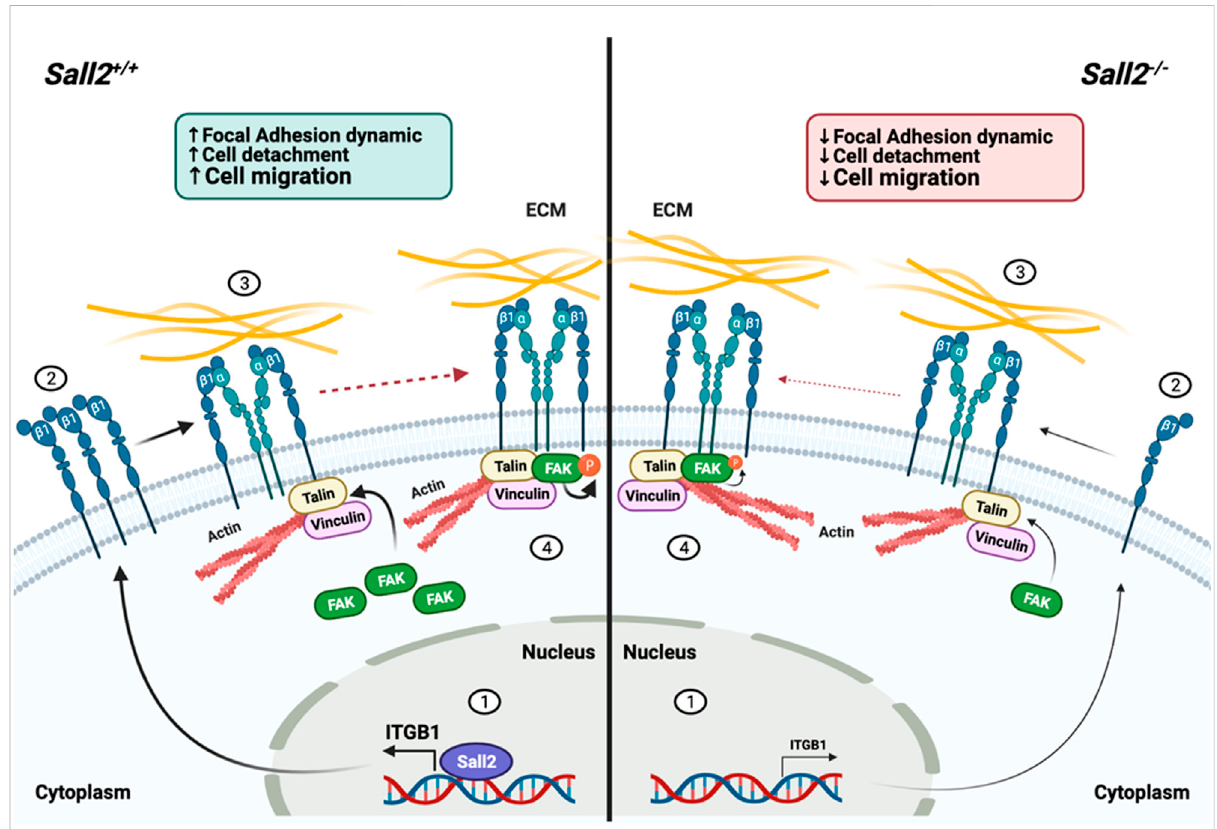
FIGURE 7 Proposed model of Sall2-dependent regulation of cell migration. In Sall2 +/+ iMEFs cells, (1) Sall2 promotes the integrin β 1 mRNA expression by directly binding to and transactivating its promoter, (2) increasing the integrin β 1 protein levels and its expression at the membrane surface, contributing in part to the integrin β 1 cluster formation. (3) After integrin ligand-binding, actin-associated proteins like talin and vinculin bind to the integrin β 1 andrecruit focaladhesionkinase(FAK). (4) Once recruited in theadhesion site, FAK isautophosphorylated modulating FA assembly- disassembly dynamics. Conversely, in Sall2 − / − cells the same chain of events occurs but less favorably. In summary, Sall2 by promoting the FA dynamics favors cell detachment and subsequently cell